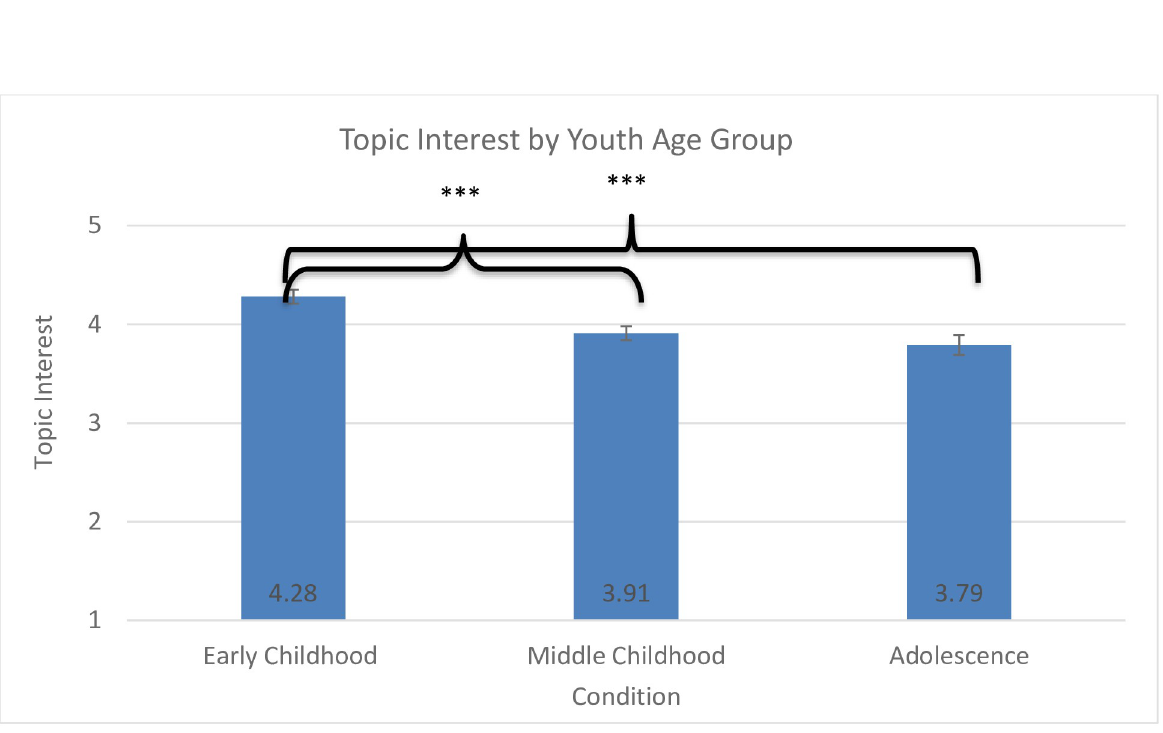
Fig 2. Topic interest by youth age group. � p < .005, �� p < .01, ��� p < .001.